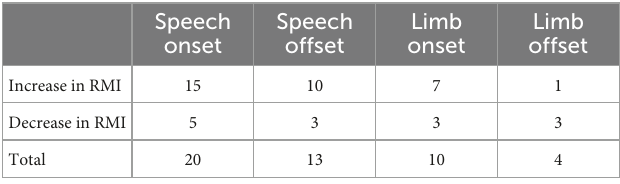
TABLE 3 Modulation patterns of the 41 identified STN multi-unit clusters relative to speech and limb movement onset and